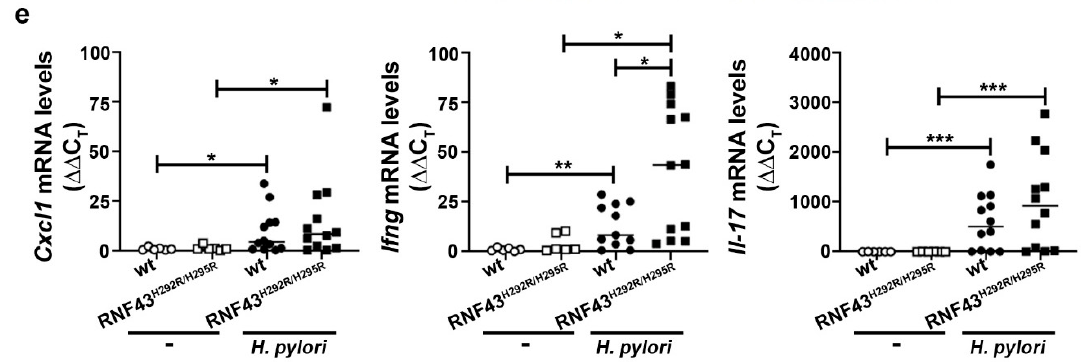
Figure 1. H. pylori infection worsens gastric inflammation of RNF43 H292R/H295R mice. ( a ) Gastritis score. Gastric inflammation was assessed according to the updated Sydney system for gastritis classification after 6 months of infection with the H. pylori strain PMSS1. ( b ) Representative images of H&E stained gastric sections showing infiltration of inflammatory cells (arrows) in the corpus of control and PMSS1 infected mice. ( c ) Quantification (positive cells per high power field (20 × objective)) and representative images of chloracetate esterase (CAE) stained tissue samples. ( d ) Quantification of CD3 + cells per high power field and representative images of stained tissue samples. ( e ) mRNA levels of Cxcl1 , Ifng and Il-17 detected in gastric homogenates. Values were normalized to Gapdh and differences expressed as ΔΔ C T to control uninfected mice. * p ≤ 0.05; ** p ≤ 0.01; *** p ≤ 0.001; **** p ≤ 0.0001. Mann-Whitney Test (pairwise comparisons).